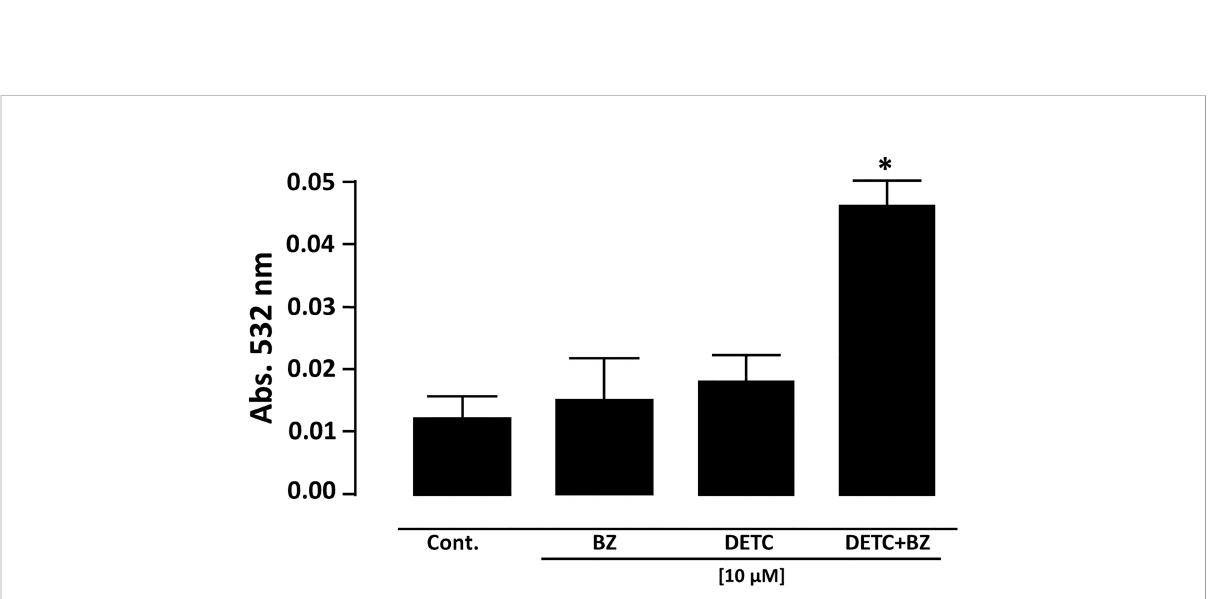
FIGURE 7 Measurement of lipid peroxidation in T. cruzi epimastigote forms (Y strain) by determination of thiobarbituric acid reactive substances (TBARS). Parasite cells treated with 10 µM DETC and 10 µM BZ combination for 24 h presented a signi fi cantly (* p < 0.05, ANOVA and Dunn ’ s post-test) increased lipoperoxidation. Bars represent mean ± SD (n =